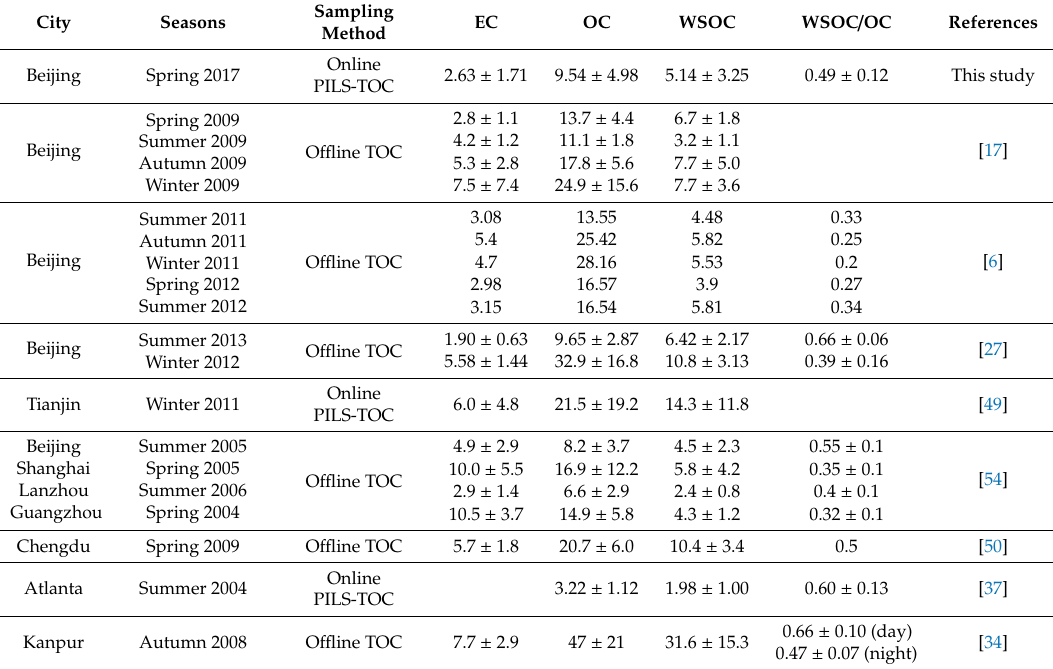
Table 2. Concentrations ( µ g / m 3 ) and ratios of carbonaceous components reported in di ff erent studies.